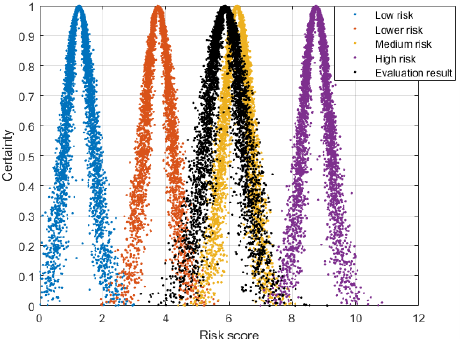
Figure 5. Cloud Chart of Comprehensive